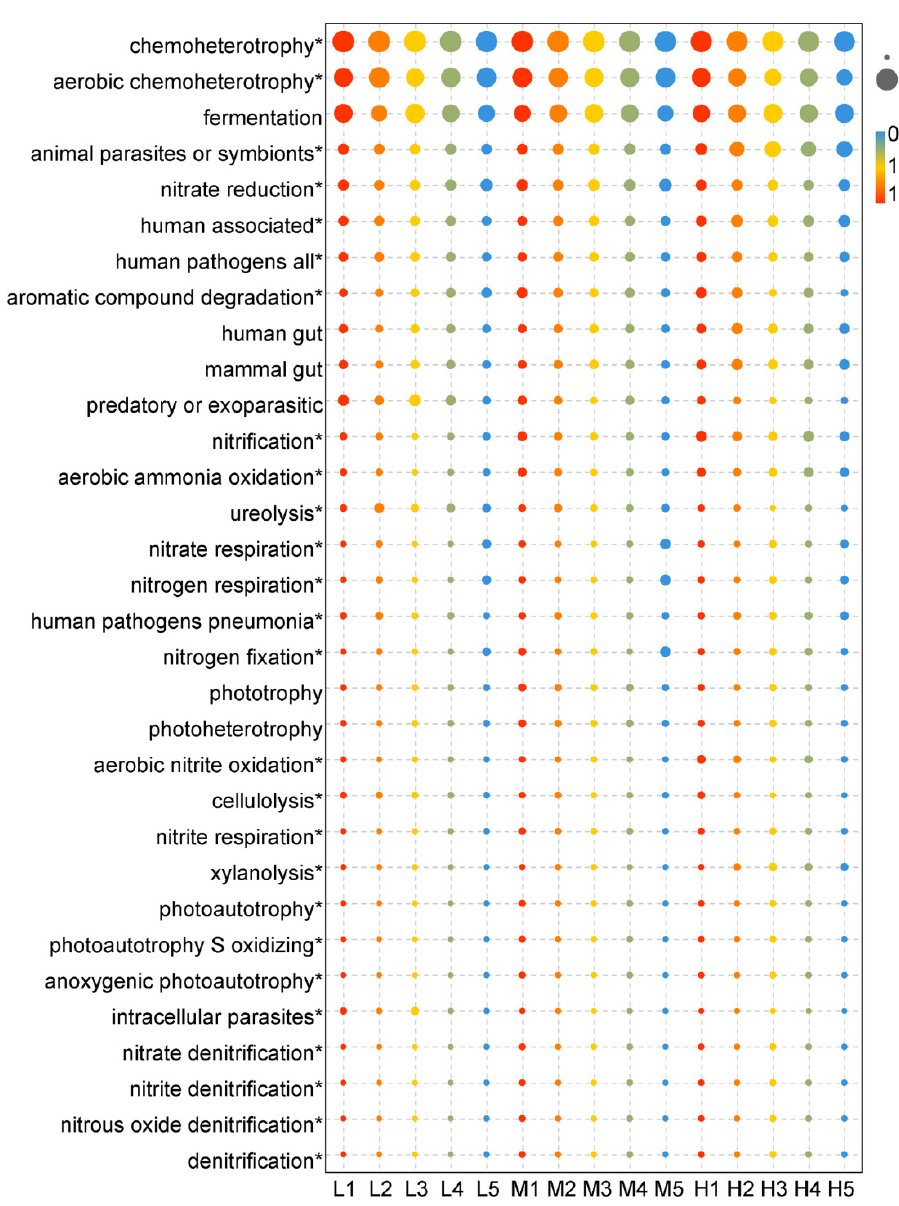
Figure 12. Ecological functional diversity of soil bacterial community in different altitudes and distances. * p < 0.05.